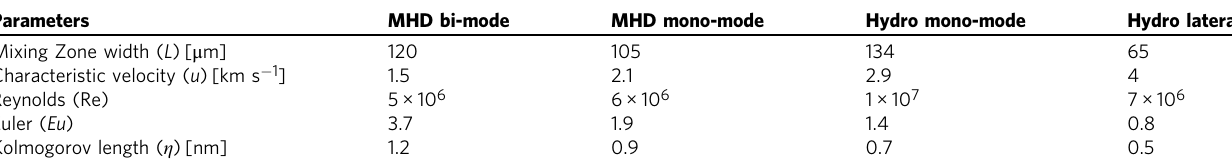
Table 2 Alternative values of the plasma parameters. This table is an alternative of the value found in Table 1 when using the reference frame of the expanding interface. Since the values presented here depend on the RTI development, only values obtained using the 2D simulations (FLASH) are shown. The last column of the table corresponds to value taken in the transverse direction. L is the spacing between spike and u the lateral variation of velocity. This values were take from the hydrodynamic simulation of the mono-mode case.